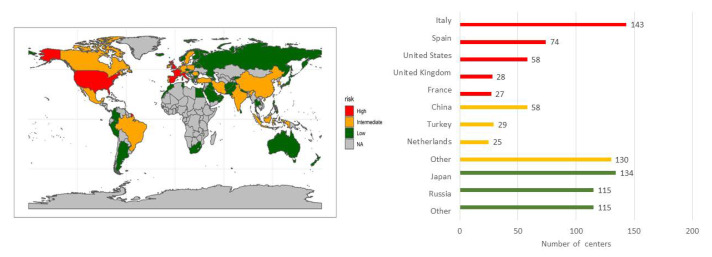
Country’s risk category and number of centers. Countries were classified into high (>5000), intermediate (100-5000) and low (<100) risk groups based on the number of cumulative deaths reported by the WHO on April 8, 2020. Other countries in intermediate risk (n = 130): Mexico (24), Portugal (17), Romania (13), Austria (12), Germany, India, Ireland (10), Belgium (8), Brazil, Switzerland (5), Canada, Sweden (4), South Korea (3), Indonesia (2), Denmark, Iran, and Poland (1). Other countries in low risk (n = 115): Ukraina (11), Azerbaijan (9), Pakistan (8), Egypt, Israel (6), Greece, Lithuania, Norway (5), Belarus, Colombia, Lebanon (4), Australia, Czech Republic, Sri Lanka (3), Argentina, Armenia, Bulgaria, Finland, Latvia, Moldova, Puerto Rico, South Africa, Thailand (2), Afghanistan, Hungary, Iceland, Iraq, Israel, Korea, Kyrgyzstan, Morocco, Nepal, New Zealand, North Macedonia, Oman, Palestine, Panama, Perú, Philippines, Saudi Arabia, Serbia, Singapore, Tunisia, United Arab Emirates (1).